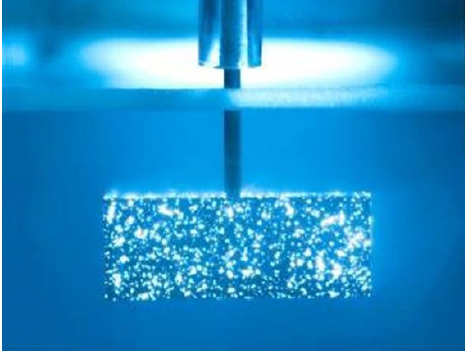
Figure 3. The schematic diagram of the MAO process.